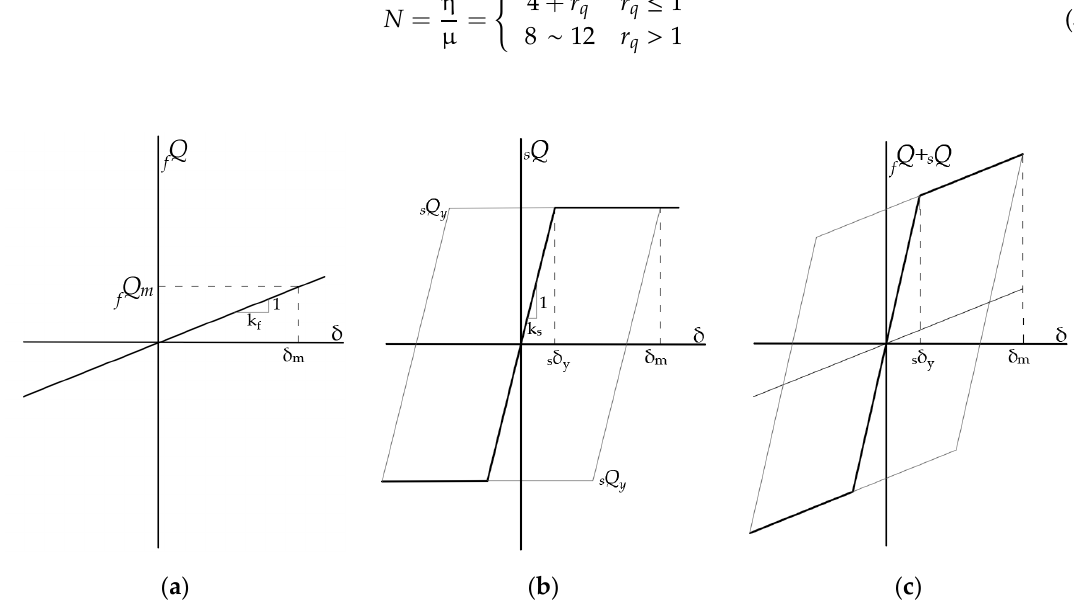
Figure 2. Load-deformation curves in flexible-stiff mixed systems: ( a ) flexible part; ( b ) stiff part; ( c ) mixed system.